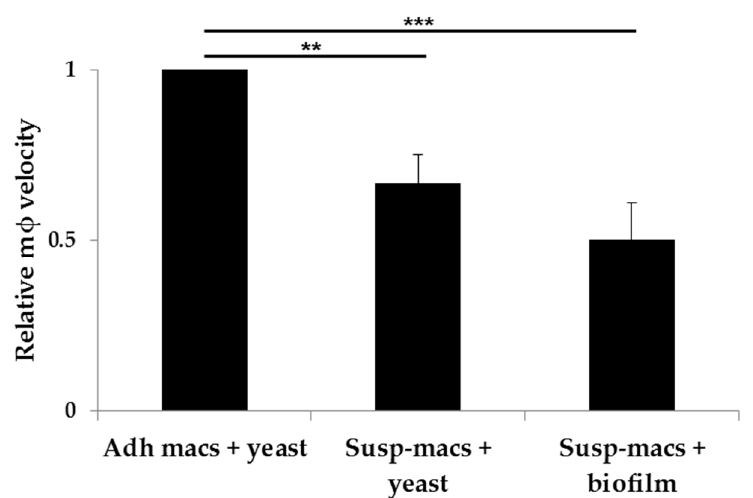
Figure 4. Quantitative analysis of macrophage migration in the presence of different wildtype C. albicans . This chart shows mean relative macrophage velocity + SD, relative to macrophage velocity of pre-adhered J774.1 (Adh-macs) responding to planktonic yeast. Relative velocities of J774.1 macrophages added in suspension (Susp-macs) to either yeast or a 48 h biofilm over a 30 min period are shown. Statistical significance was evaluated using one-way analysis of variance (ANOVA) and Tukey Multiple Analysis Comparison Tests. ** p < 0.01; *** p < 0.001; ( n = 3).